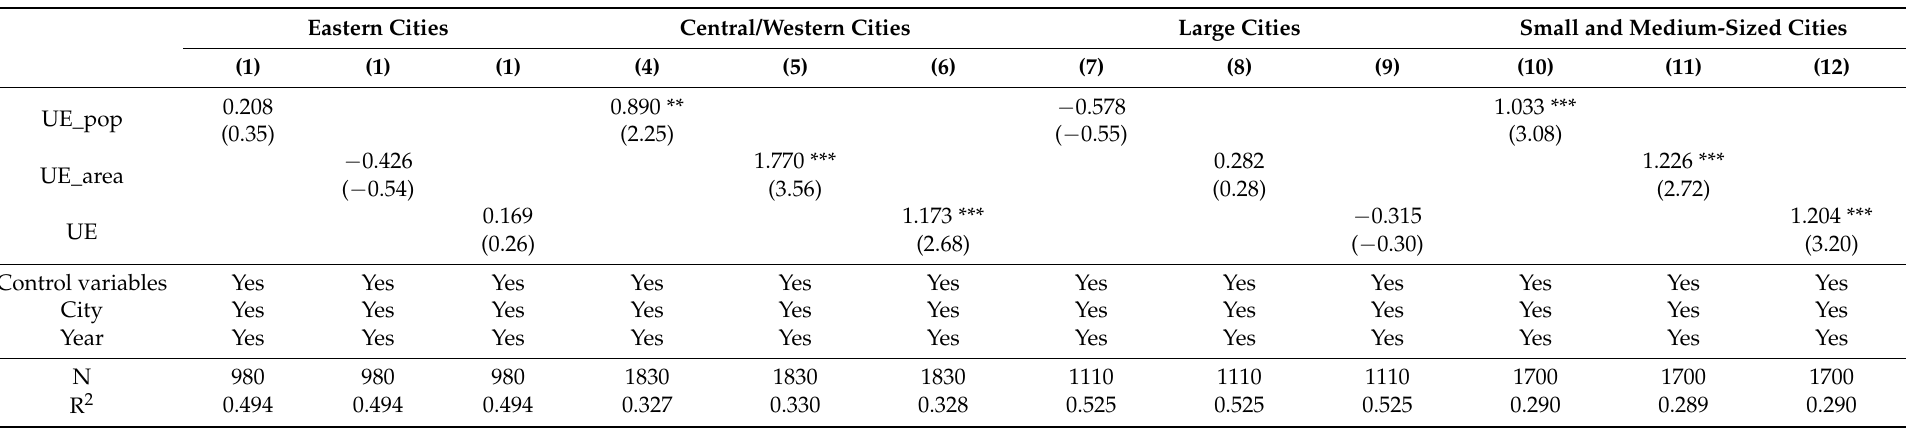
Table 5. Regression results of heterogeneity of regions and sizes of cities.